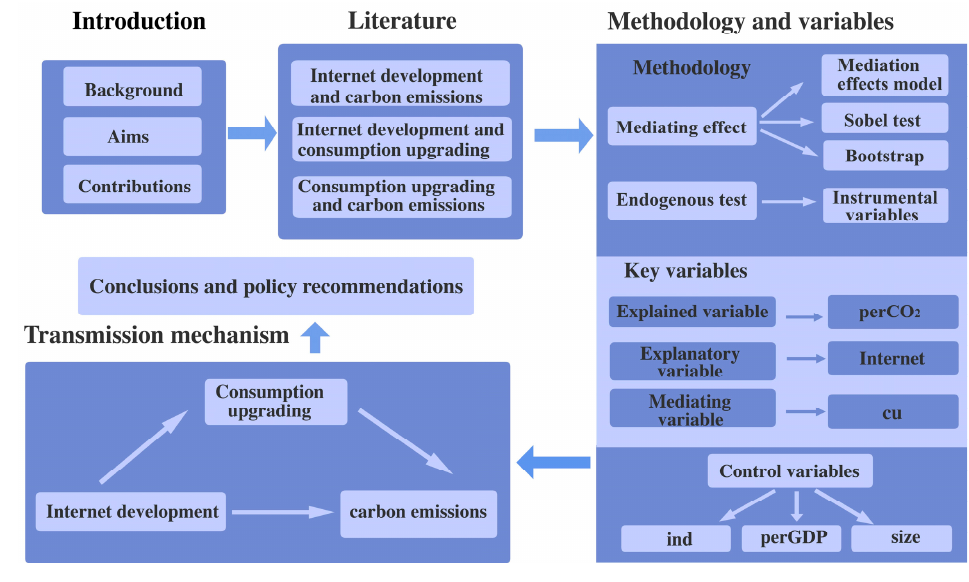
Figure 1. Analysis framework.